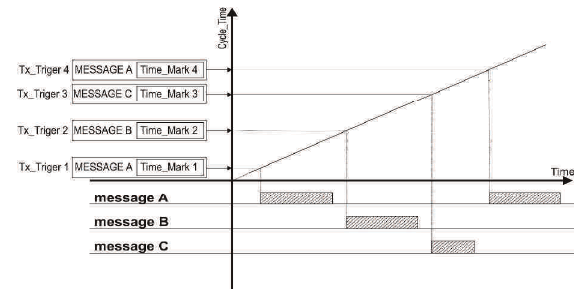
Fig. 3. Scheme of TTCAN message